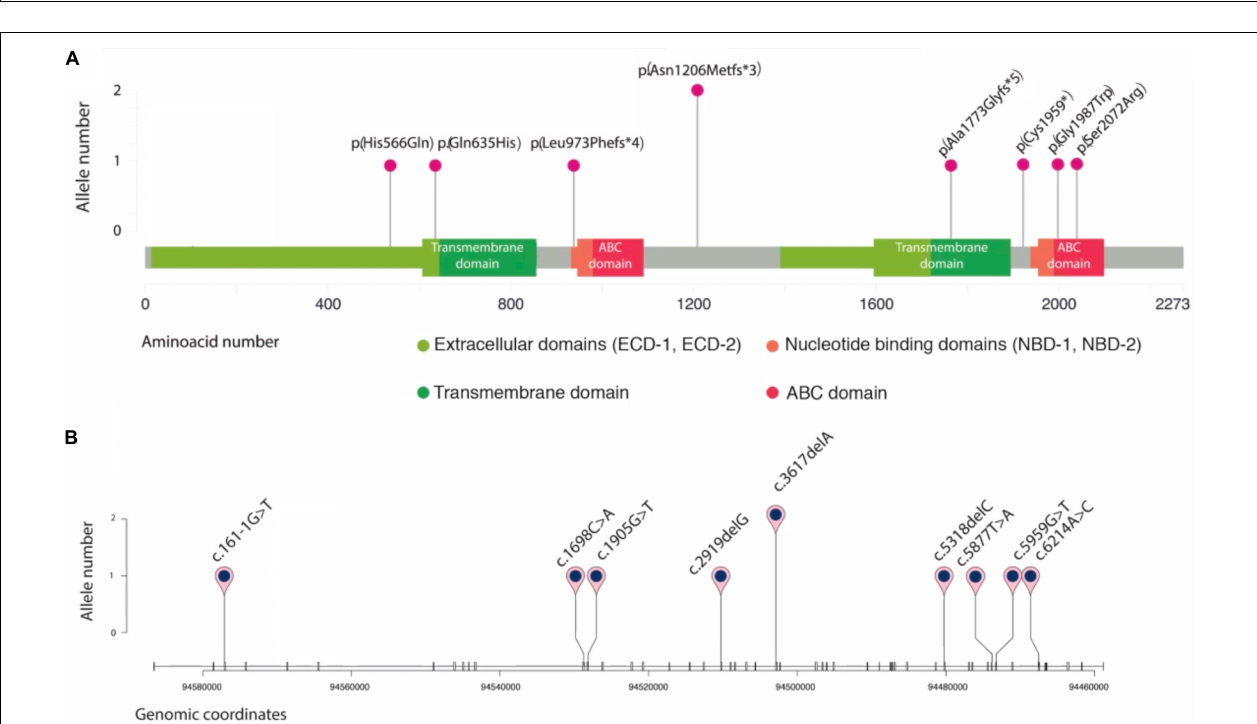
FIGURE 4 | Schematic representation of novel ABCA4 variants found in eight unrelated patients. Plots are adapted from cBioportal’s MutationMapper and R package trackViewer. Variants are displayed in two contexts: (A) : linear ABCA4 protein sequence (NP_000341.2), highlighting its typical A-subclass ABC transporter domains, and (B) : ABCA4 gene sequence (NM_00350.2), where each tick represents an exon. Genomic coordinates correspond to hg19/GRCh37 human reference genome.